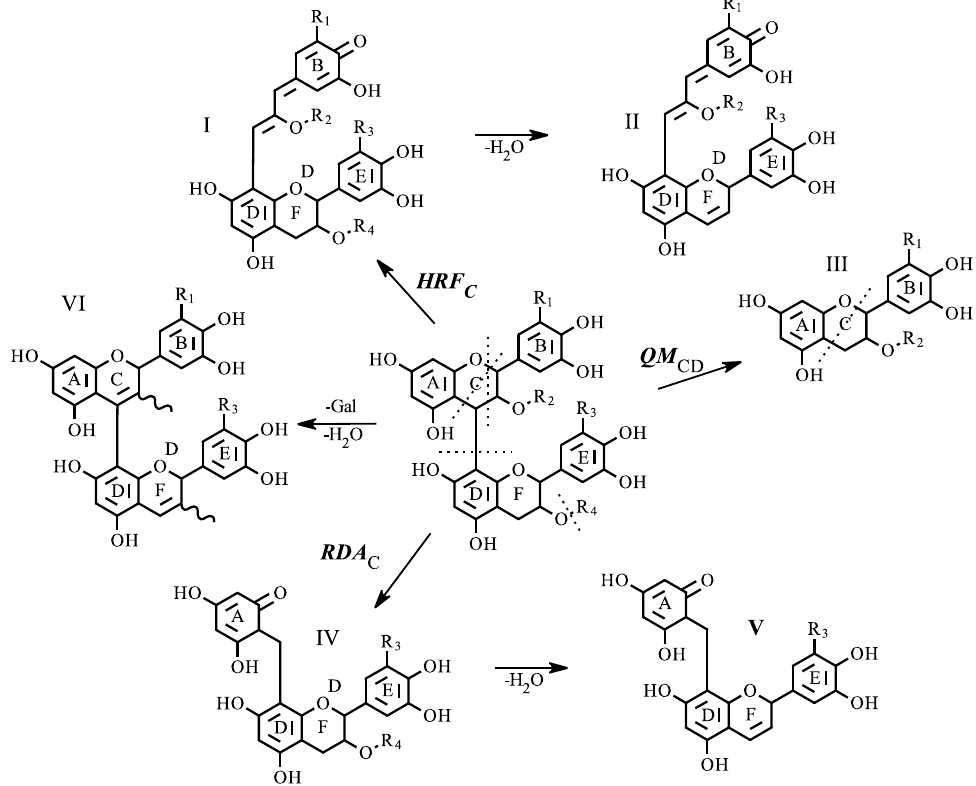
Figure 3. Characteristic proanthocyanidin fragmentation pathways. Three primary fragmentation mechanisms are shown: Heterocyclic Ring Fission (HRF), quinone methide fission (QM), and retro Diels-Alder (RDA); subscripts C or CD indicate the fragmentation location in the rings of the subunit; each yield structures I, III, and IV, as indicated. Further losses of water and gallate (II, V, VI) are also indicated. For each structure; R 1 = R 3 = OH, H: R 2 = R 4 = H, Gallate.